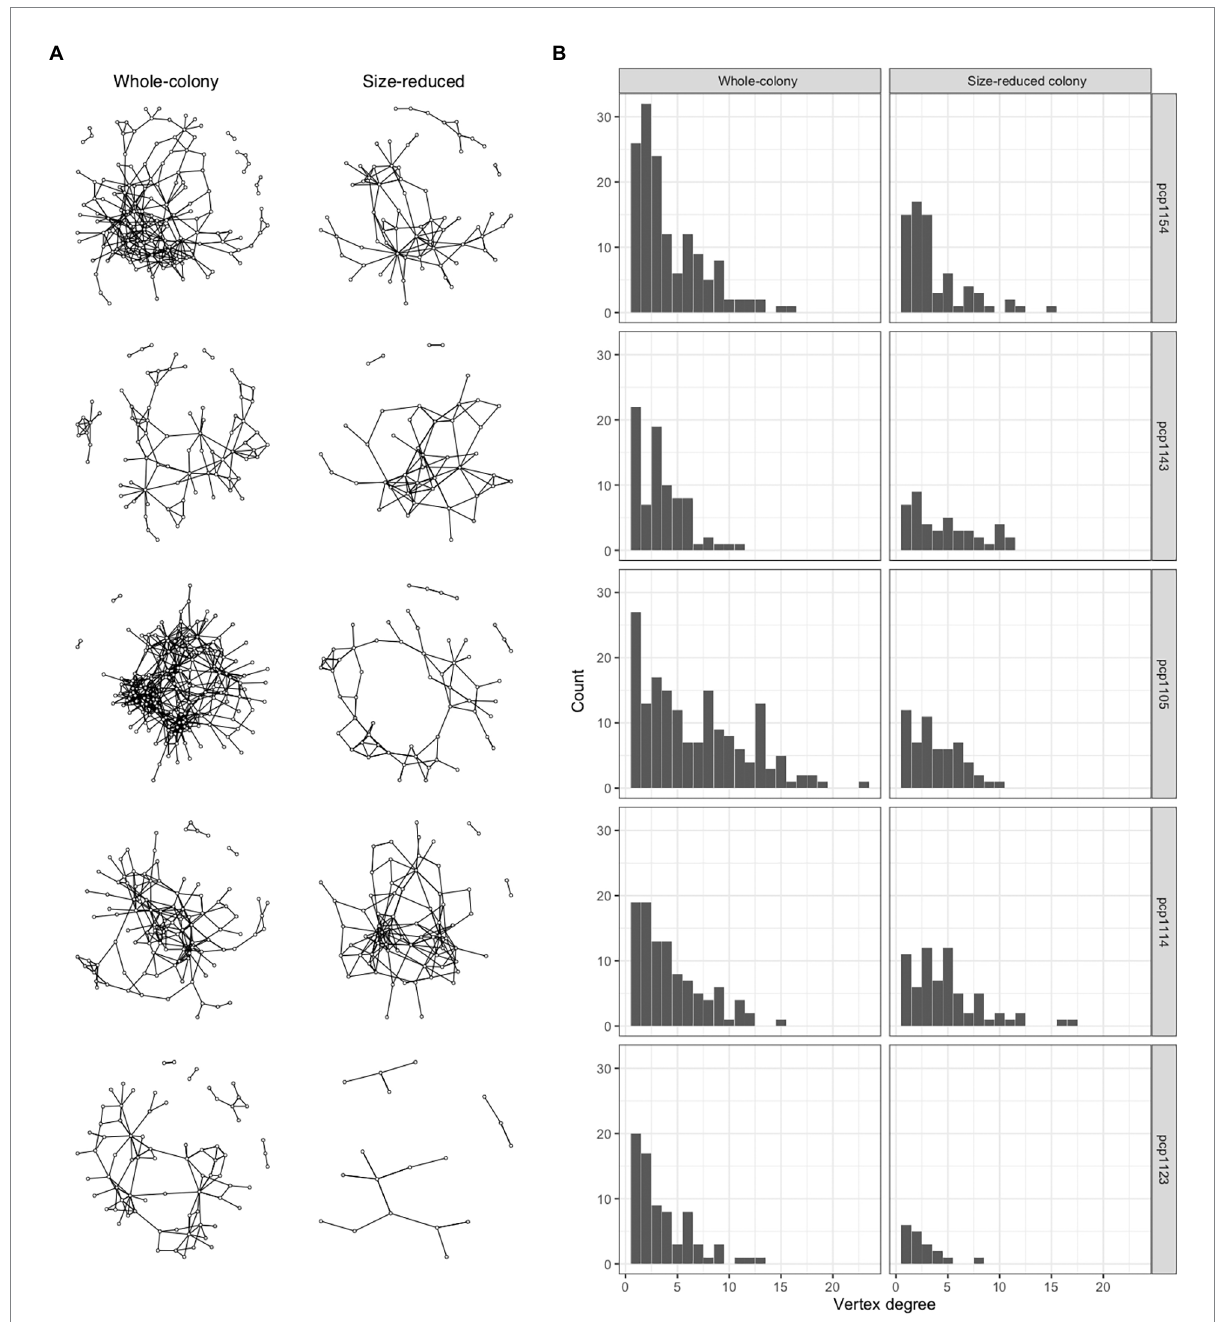
FIGURE 1 Social networks of P. californicus colonies. (A) These graphs show the 10 networks summarizing the interactions between workers in five colonies. The graphs in the column on the left were based on interactions in the whole-colonies prior to their manipulation, the graphs on the right are based on interactions in the same colonies, but after a manipulation in which 50% of the workers, brood, and pupae had been removed. (B) Degree distributions are plotted corresponding with the respective networks shown in (A) as determined by observing antennal